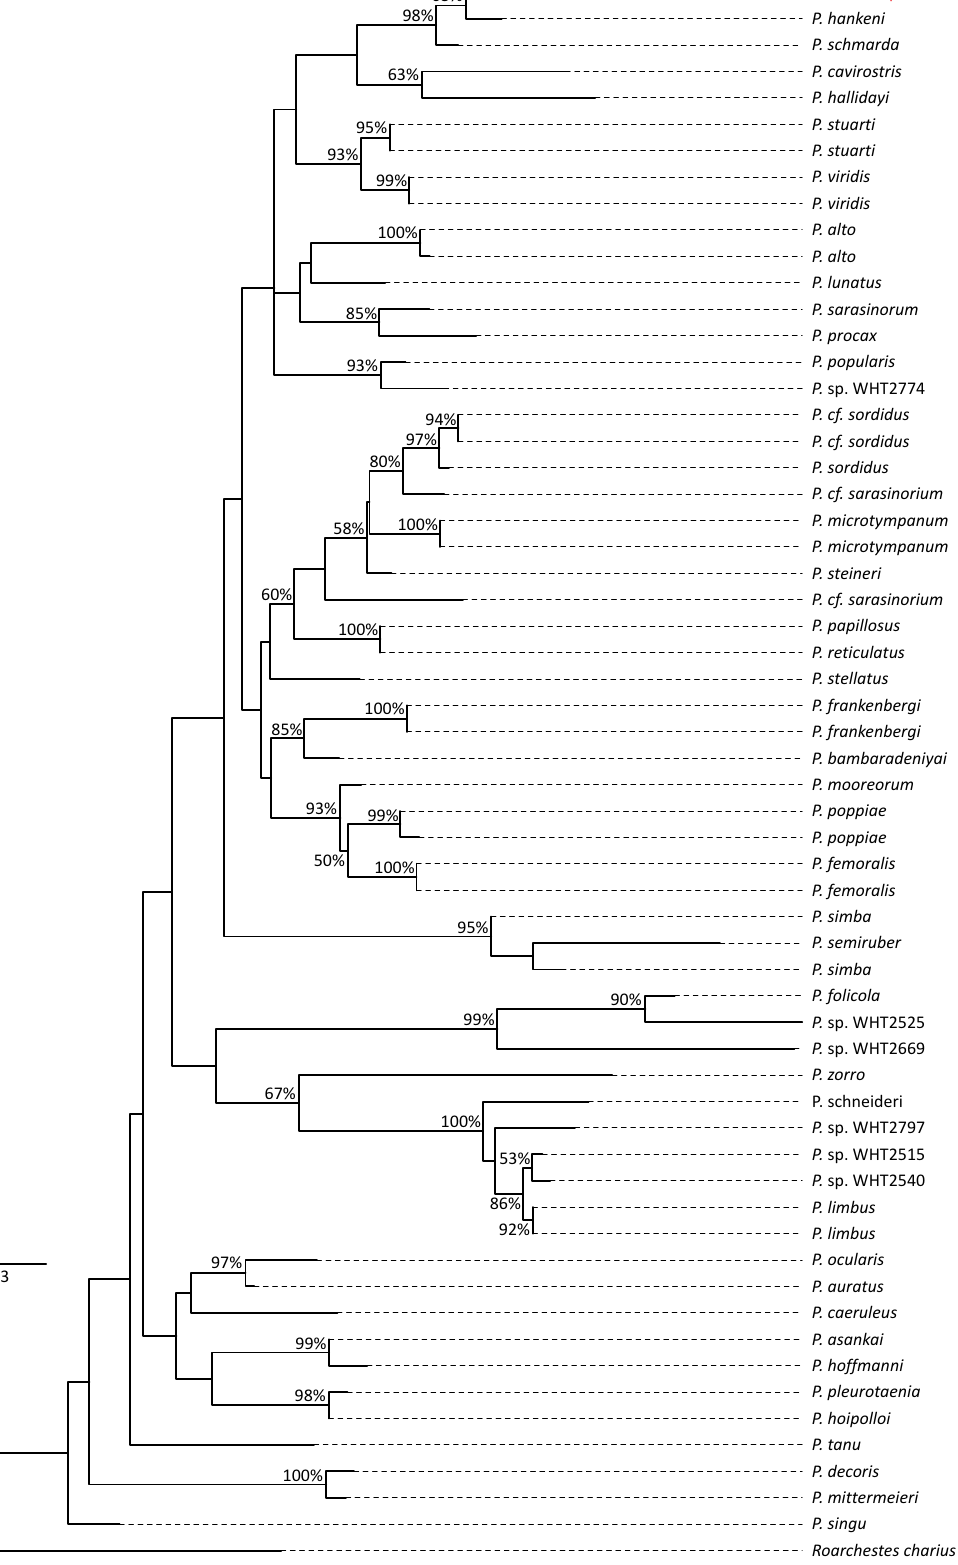
Figure 2. Maximum likelihood tree of 16S rRNA gene fragments, with bootstrap values shown at nodes. Pseudophilautus dilmah sp. nov. (marked with an asterisk) is placed in a monophyletic clade with P. schmarda and P. hankeni